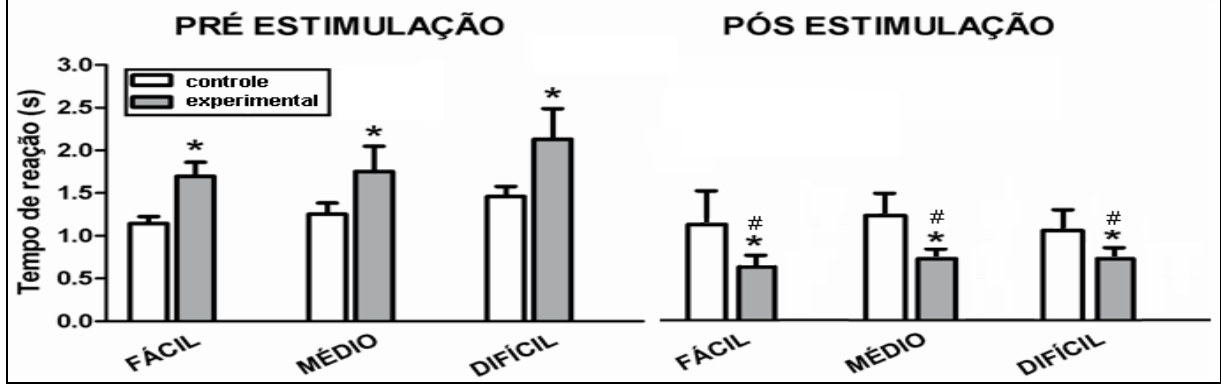
Figura 4. Tempo de reação. A figura indica o tempo de reação ao estímulo luminoso acionado sincronicamente com a EMG. Verifica-se o grupo controle e experimental nos testes fácil, médio e difícil;